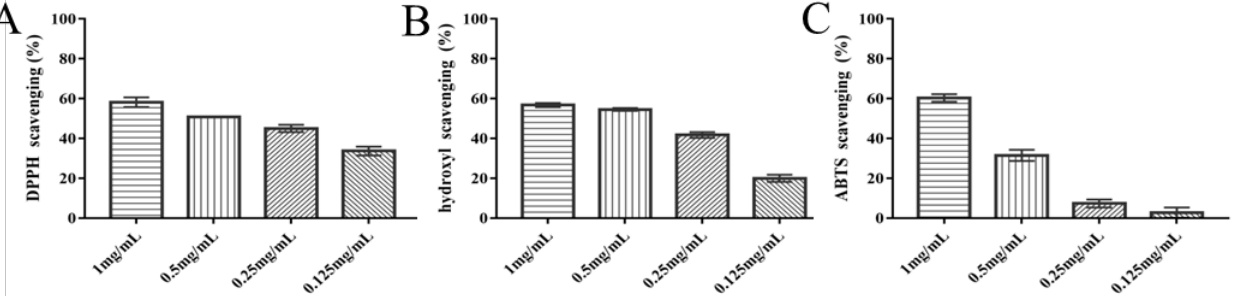
Figure 1. Antioxidant activity of CIP in vitro. ( A ) DPPH radical scavenging activity; ( B ) ABTS radical scavenging activity; ( C ) hydroxyl radical scavenging activity ( n = 3).